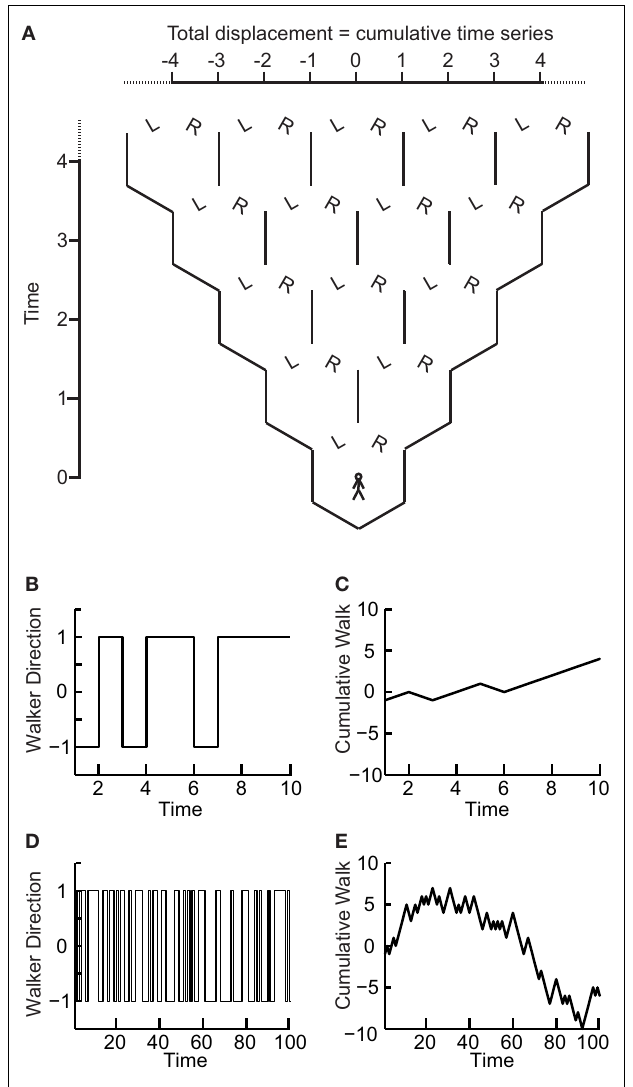
FIGURE 2 |The “random walk”: the signal profile of a stationary time series may reveal self-affinity. (A) At each time step a walker moves randomly to the left ( − 1) or right ( + 1) with equal probability. At any time step the probability of being at a certain displacement from the origin depends on the number of different paths that could take the walker there. (B) The walker’s steps form a time series that is stationary as its value does not depend on time. (C) The signal profile can take arbitrarily large values as the time increases. (D) Looking at the walker time series on a longer time-scale the standard deviation does not change as the signal cannot take larger values. (E) The cumulative sum, or random walk process, on a longer time-scale shows larger variance than on the shorter time-scale (C) therefore the walker may exhibit self-affinity or scale-free behavior.